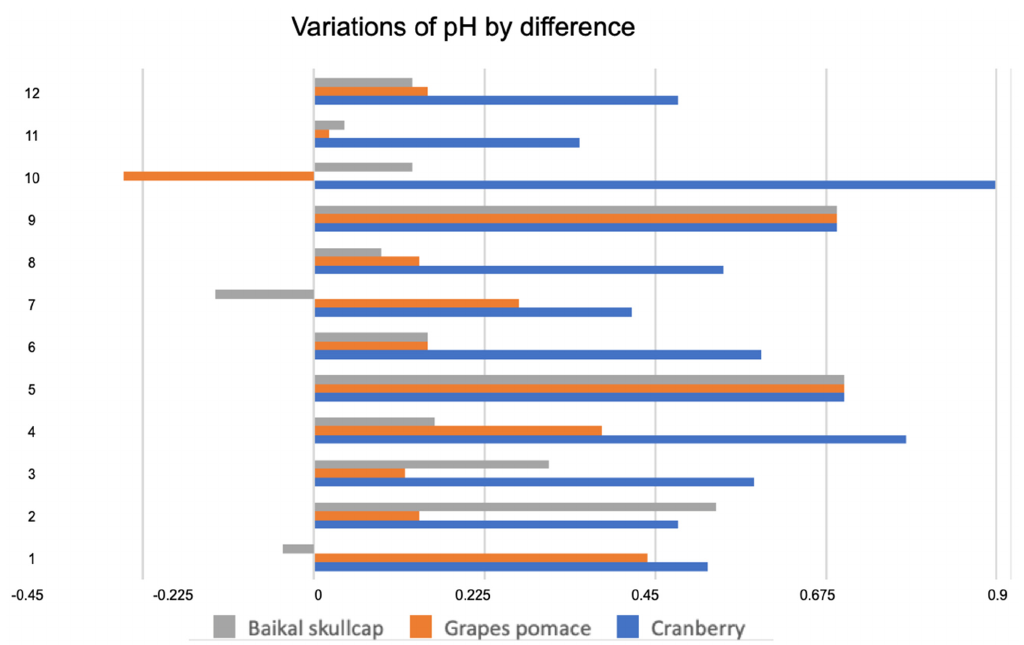
Figure 4. Variations of pH by difference across the various marinated oven-grilled chicken breast meat samples. The numbers (shown along the y -axis) represent as follows: (1) control (antioxidant additive % = 0.0); (2) control (antioxidant additive % = 0.5); (3) control (antioxidant additive % = 1.0); (4) control (antioxidant additive % = 1.5); (5) AS (antioxidant additive % = 0.0); (6) AS (antioxidant additive % = 0.5); (7) AS (antioxidant additive % = 1.0); (8) AS (antioxidant additive % = 1.5); (9) IM (antioxidant additive % = 0.0); (10) IM (antioxidant additive % = 0.5); (11) IM (antioxidant additive % = 1.0); (12) IM (antioxidant additive % = 1.5). African spice: AS; and industrial marinade/pickle: IM.